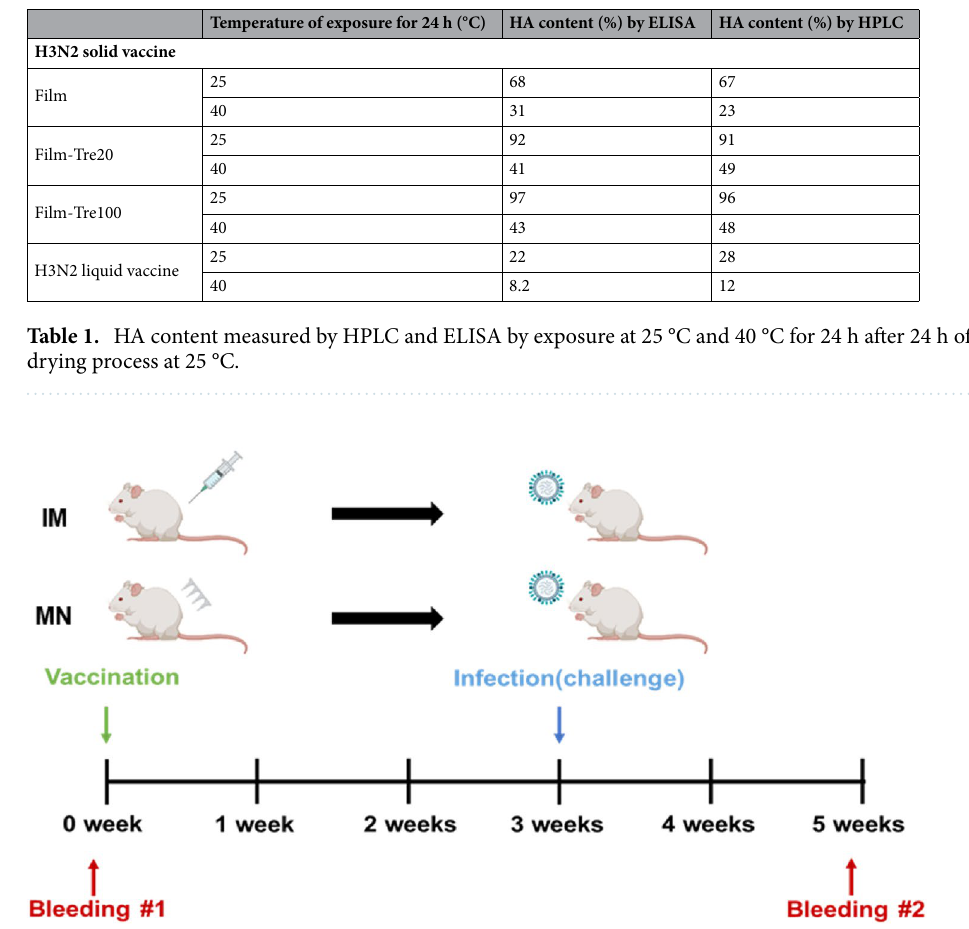
Figure 5. Brief schedule of i n vivo experiment. BALB/c mice were immunized intradermally with 19–20 A/ KS/17 H3N2 microneedle vaccines (3 μg/mouse) or intramuscularly with vaccine formulations (3 μg/mouse). Mice were infected with the mouse-adapted 15–16 A/SW/13 H3N2 virus at 3 weeks after vaccination (50MLD 50 , 30